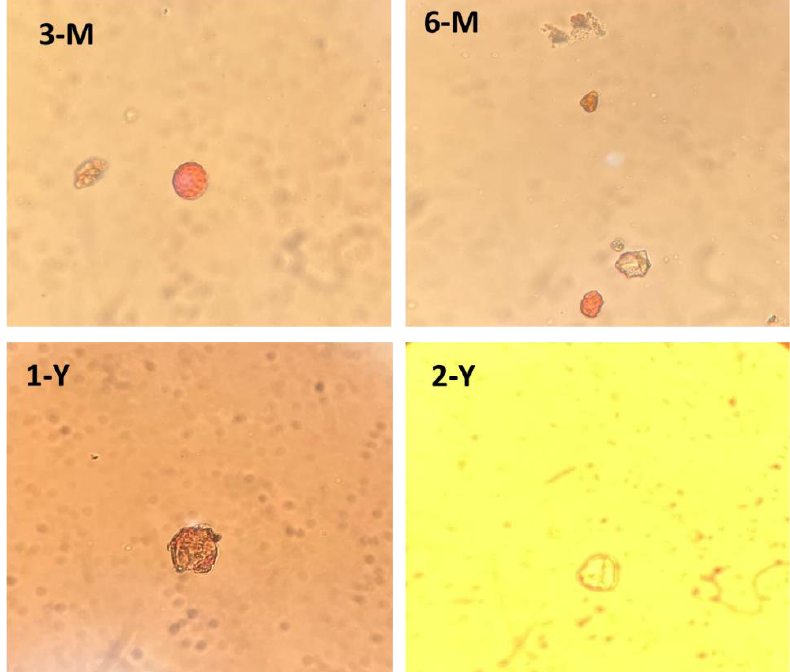
Figure 2. The pollens of the studied beeswax samples. 3-M and 6-M were of polyfloral origins. Meanwhile, 1-Y originated from Cactus opuntia and 2-Y was of Eucalyptus origin .